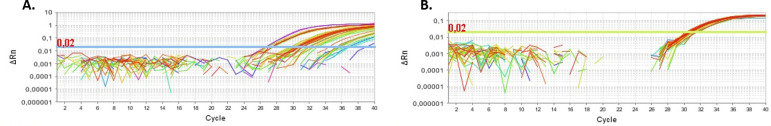
Representative amplification plots, targeting T. cruzi nuclear satellite DNA (A) and EXO-IPC DNA (B). DNA samples were extracted from GEA spiked with EXO-IPC synthetic DNA, using a silica-column based commercial kit.